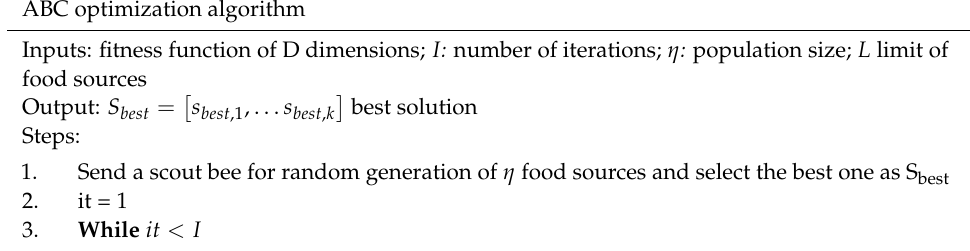
Algorithm 2. Pseudo code of the ABC algorithm .